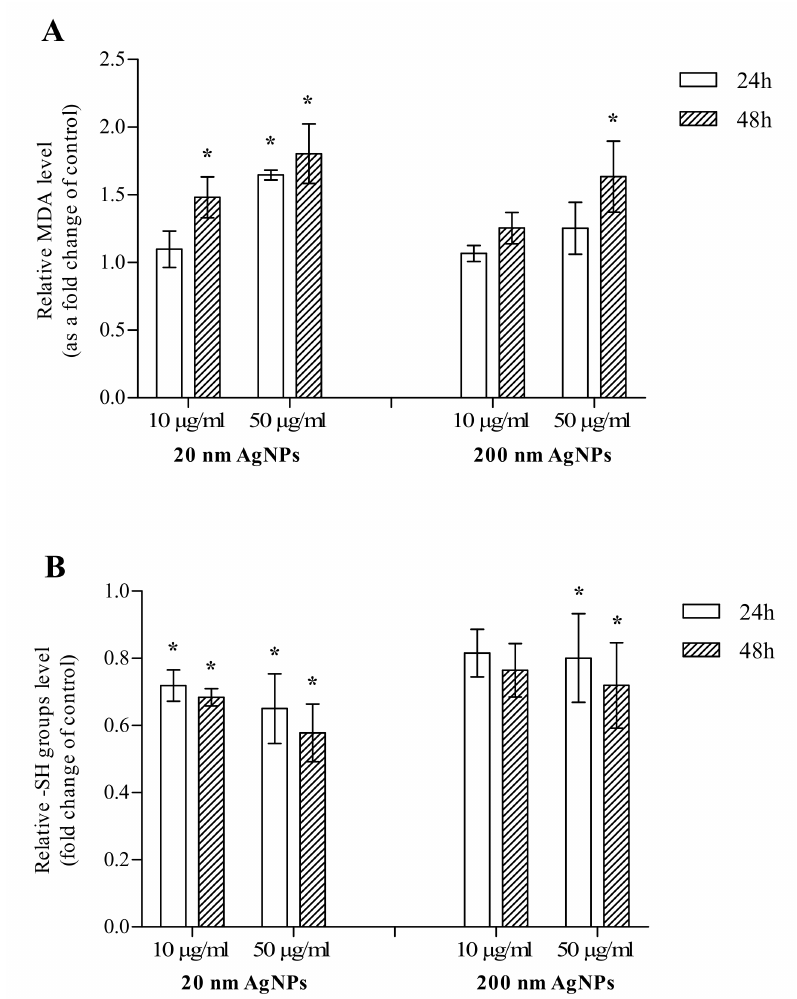
Figure 2. The level of malondialdehyde (MDA) ( A ) and thiols (-SH groups) ( B ) in MDA-MB-436 cells treated with 20 or 200 nm AgNPs. The graph presents the fold change of MDA and -SH groups level calculated for samples incubated with AgNPs relative to untreated control. The data were expressed as mean ± standard deviation ( n = 3). Statistical significance: * p <